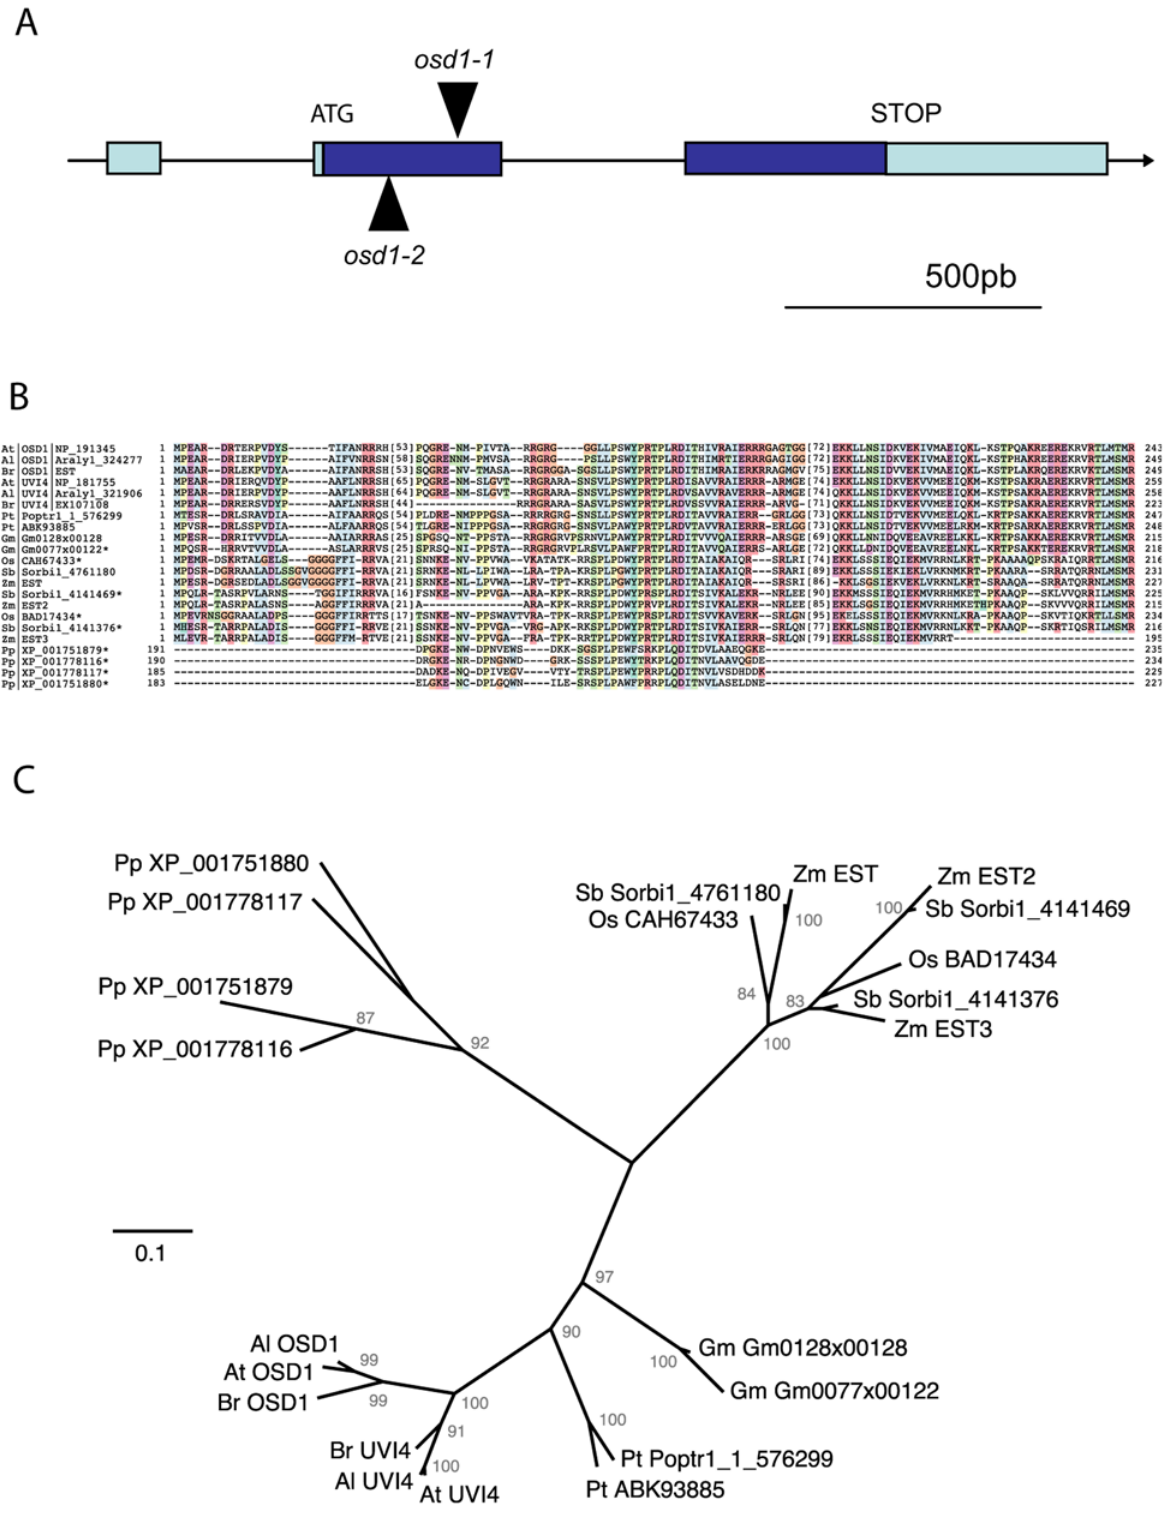
Figure 2. The OSD1 gene and protein. (A)The OSD1 gene contains three exons and two introns and encodes a protein of 243 amino acids. The positions of the two Ds insertions are indicated by triangles. (B) A multiple sequence alignment of OSD1/UVI4 family members is shown, pointing out the segments of best conservation along OSD1. Particularly high conservation is observed in the central OSD1-motif, which is the only section with clear sequence similarity in moss and club-mosses. The conserved C-terminal 40–60 amino acids are predicted to contribute to alpha-helical structural elements. All available homologues are included for the selected range of species, with the species of origin being indicated by a two letter code preceding each protein identifier. Brassicaceae: Al, Arabidopsis lyrata; At, Arabidopsis thaliana; Br, Brassica rapa. Eurosids I: Gm, Glycine max; Pt,